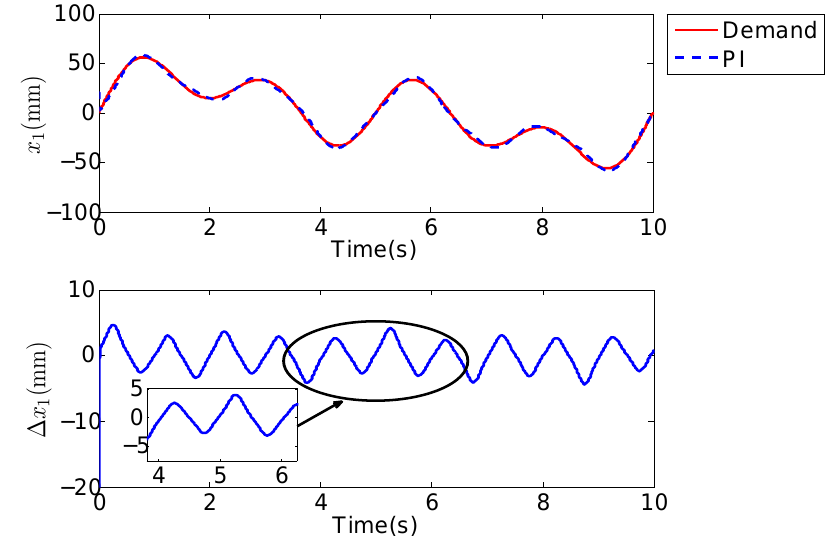
Figure 7. The cylinder position responses x 1 by PI controller with hydraulic parametric uncertainties and the external load, the demand y d = 25 ( sin ( 0.8 π t ) + sin ( 0.4 π t ) + sin ( 0.2 π t ))